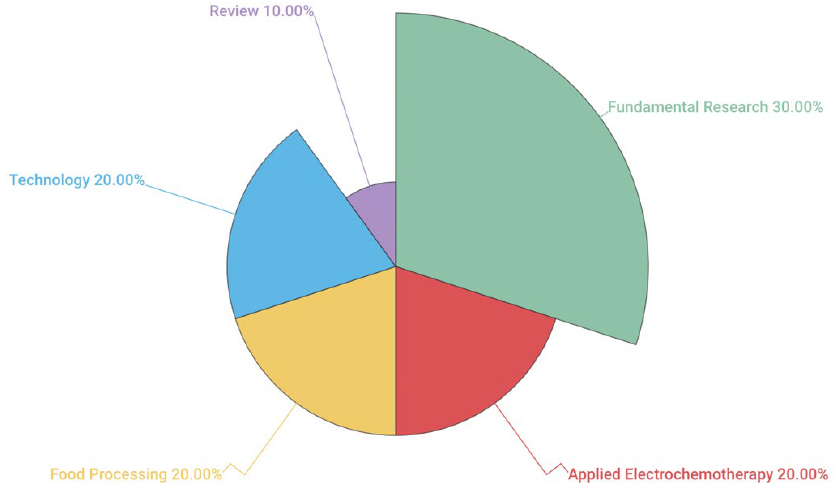
Figure 2. A summary of published articles in the Special Issue based on the covered sub-topics